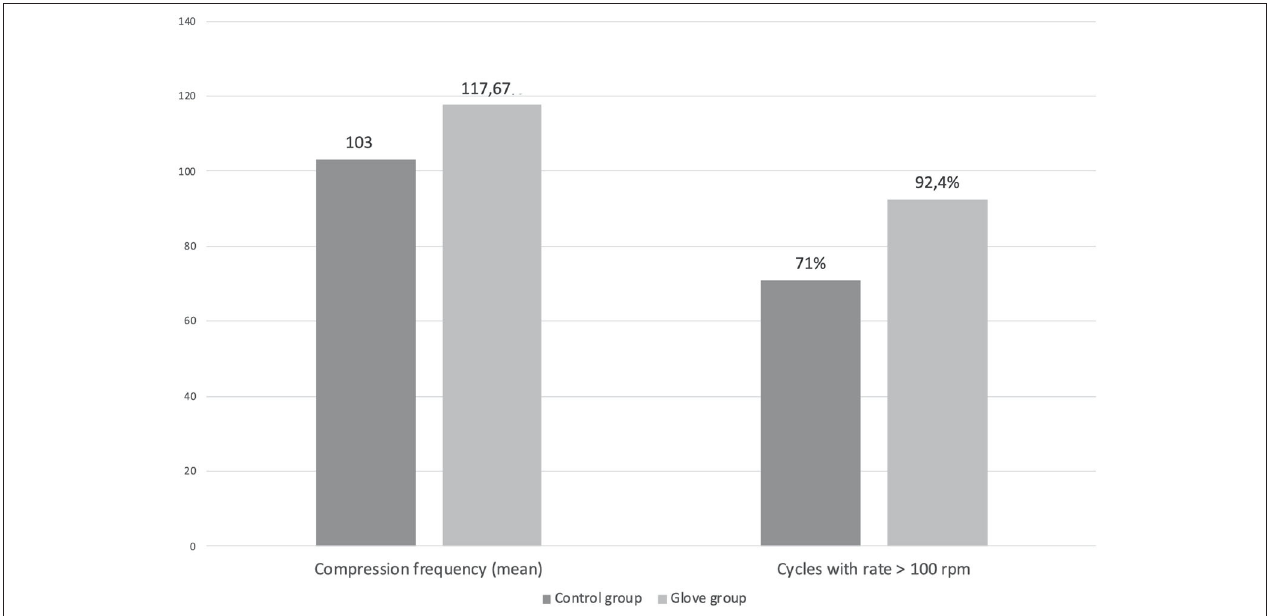
FIGURE 4 | CPR depth and frequency distribution: differences about compression frequency and cycles with a rate > 100 rpm during CPR between the two groups. All values are intended as mean values.